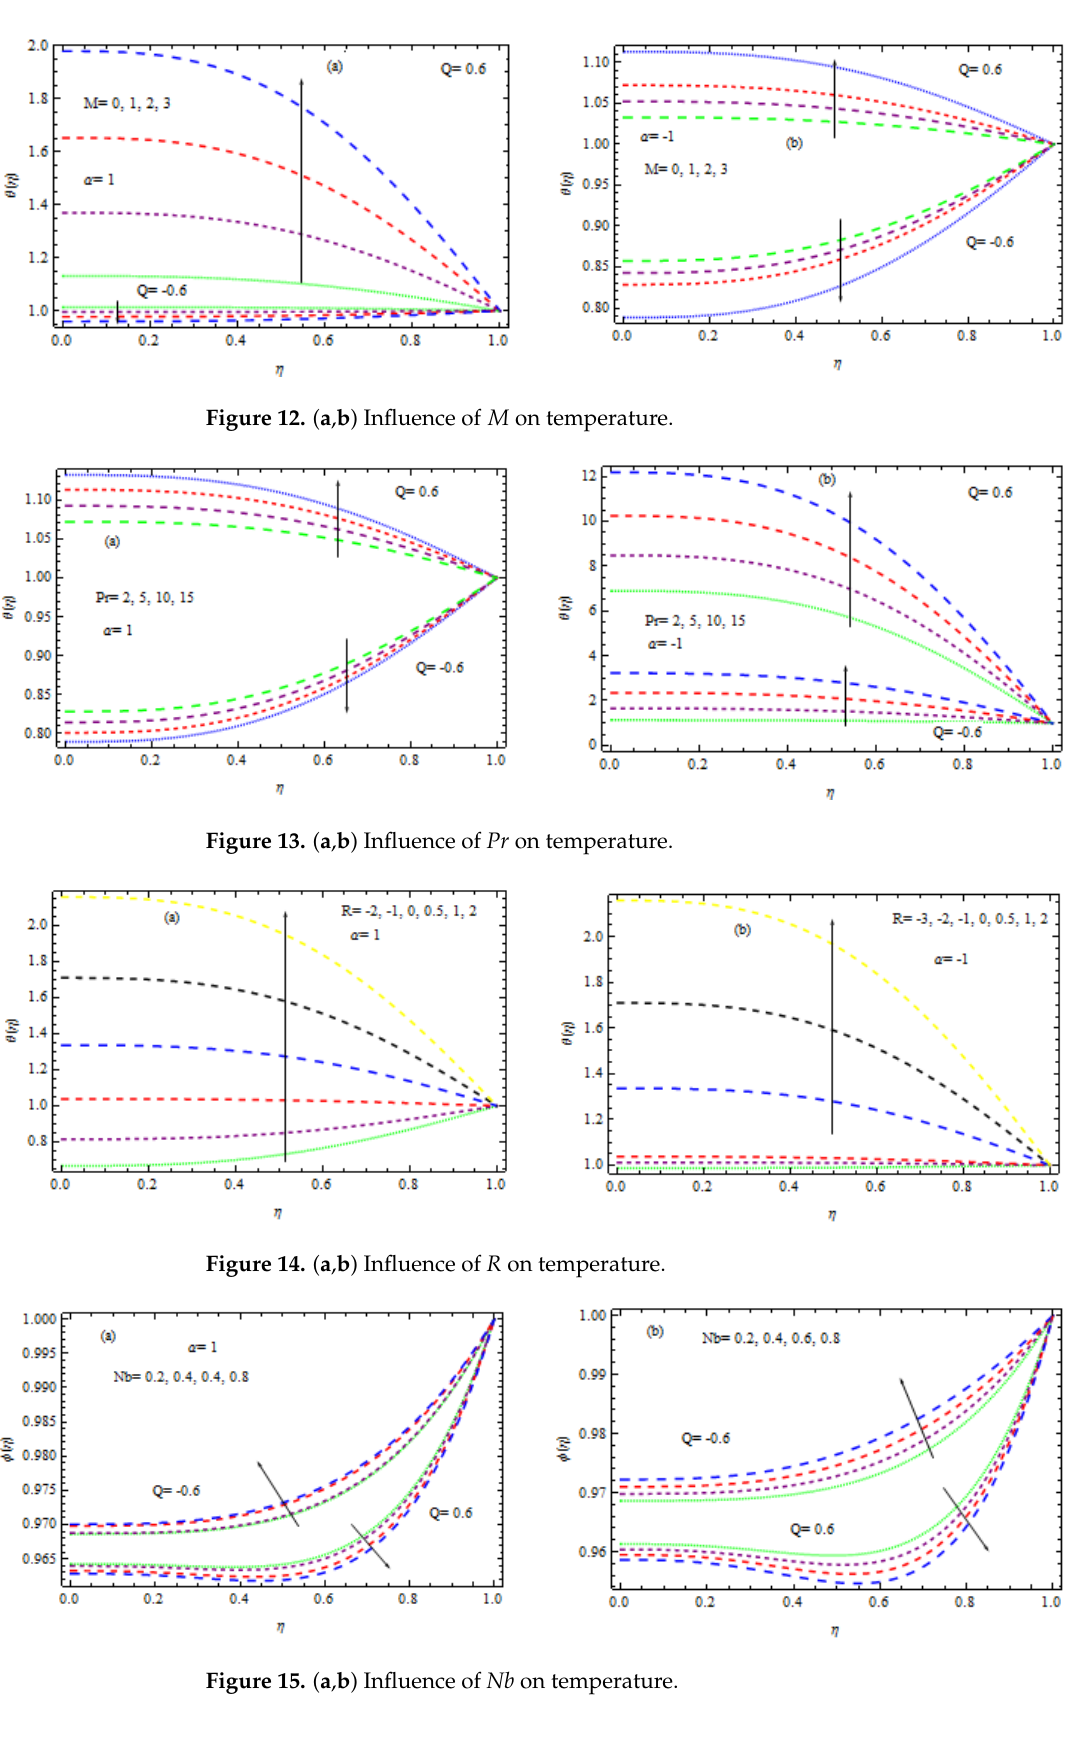
Figure 16. ( a , b ) Influence of Nt on temperature.